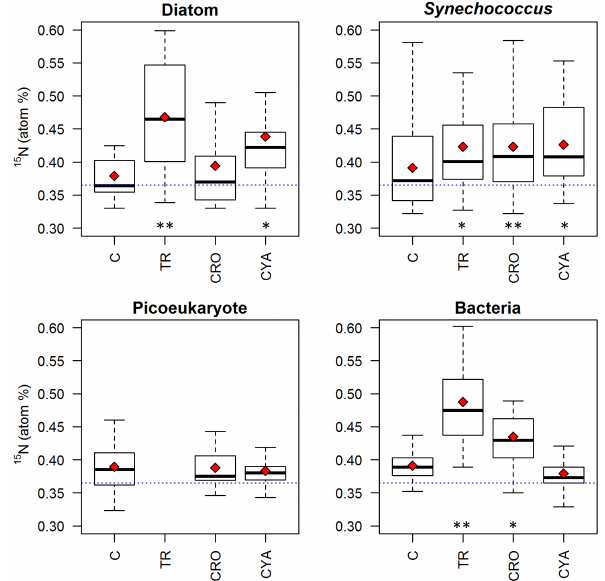
Figure 5. 15 N-enrichment (atom %) measured in T. erythraeum (red), C. watsonii (green) and Cyanothece (blue) cells relative to the 13 C-enrichment. The coloured line are the linear regressions for T. erythraeum (red), C. watsonii (green) shown with their re- spective r-squared and p-values. Regression is not significant for Cyanothece and thus not shown on the plot. Box plots of 13 C- and 15 N-enrichments are shown, following the same colour code, on horizontal and vertical axes, respectively.